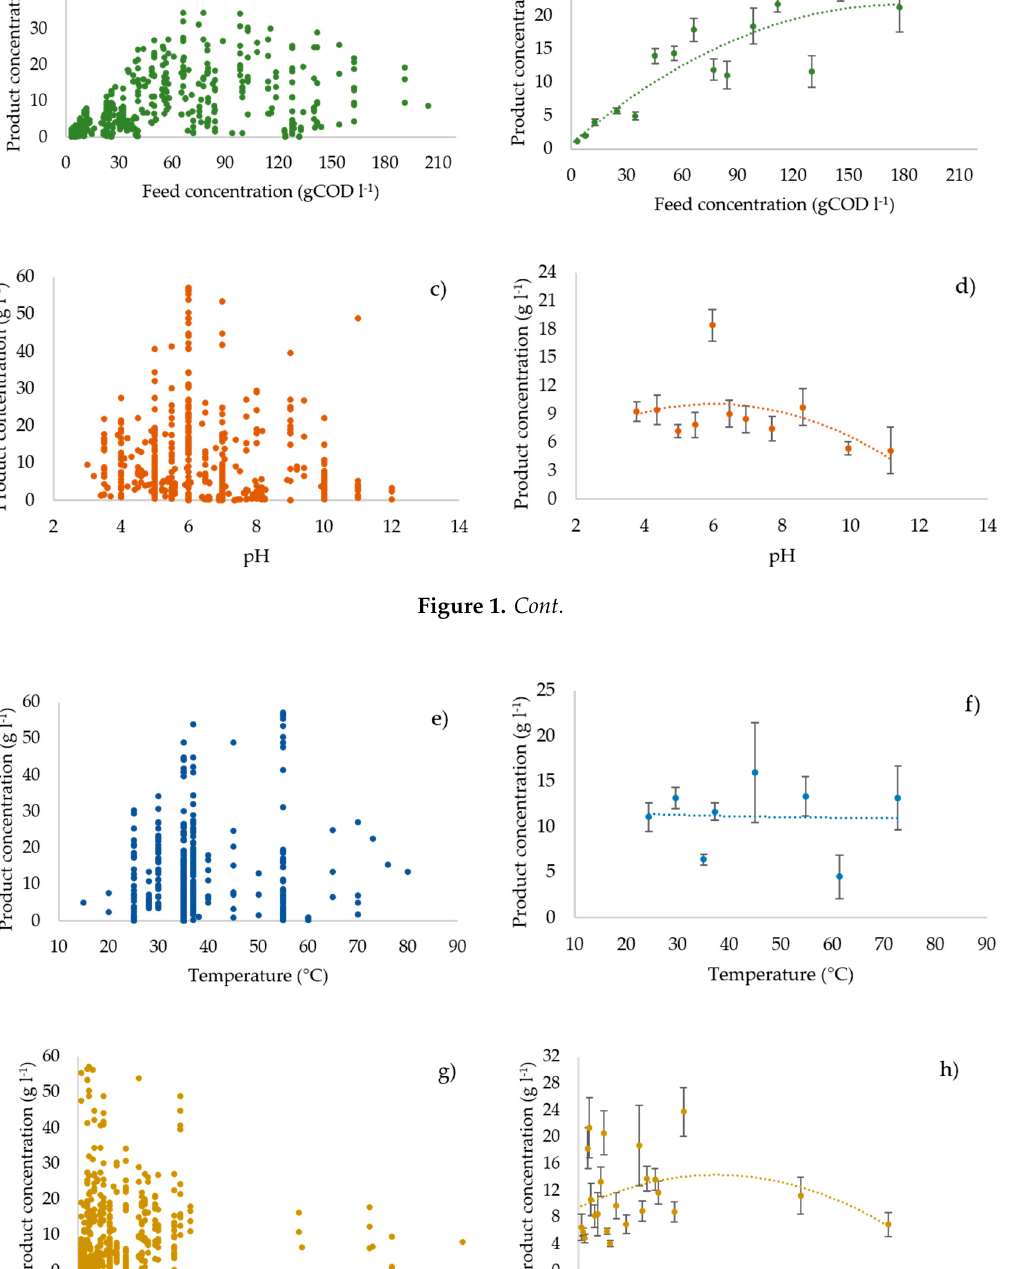
Figure 1. Relationships between product concentration and operating parameters. ( a , c , e , g ) All the considered experiments. ( b , d , f , h ) Average values of experiments in each narrow range (width maximum 20%) of the operating parameters (error bars indicate the standard error) with second grade polynomial curve. The polynomial curve is only used to visualise the general trend, without any statistical significance.